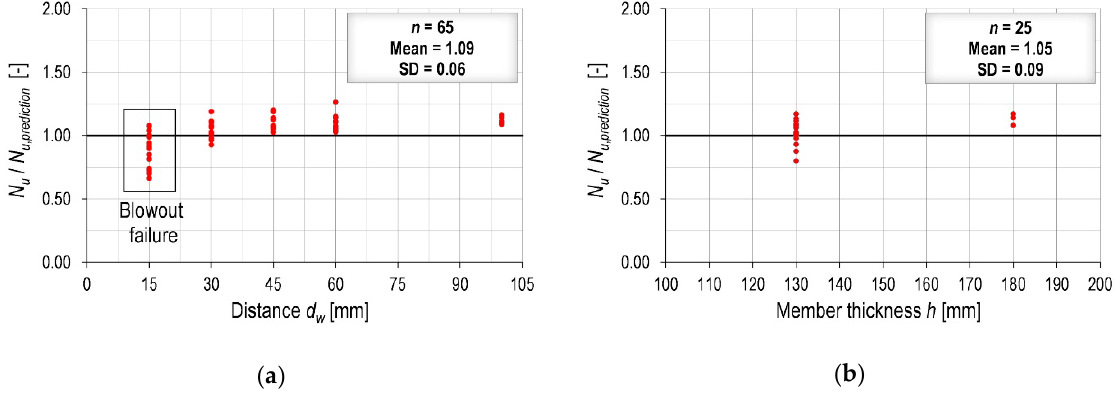
Figure 15. Numerical results compared to the new design proposal: ( a ) Series 1 and Series 2; and ( b ) Series 3. ( b ) Series